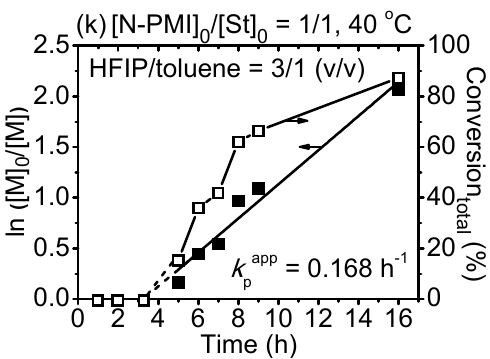
Figure 1. Polymerization kinetics of styrene (St) and N -phenylmaleimide (N-PMI) via reversible addition-fragmentation chain transfer (RAFT) copolymerization with different molar ratios, temperatures, and solvents. ( a ) in 1,1,1,3,3,3-hexafluoro-2-propanol (HFIP) and ( b ) in toluene: